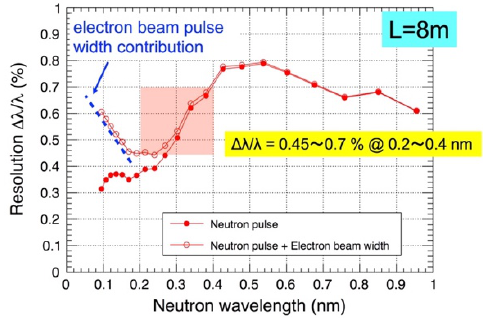
Fig. 2. Neutron wavelength resolution at L=8 m [8] .